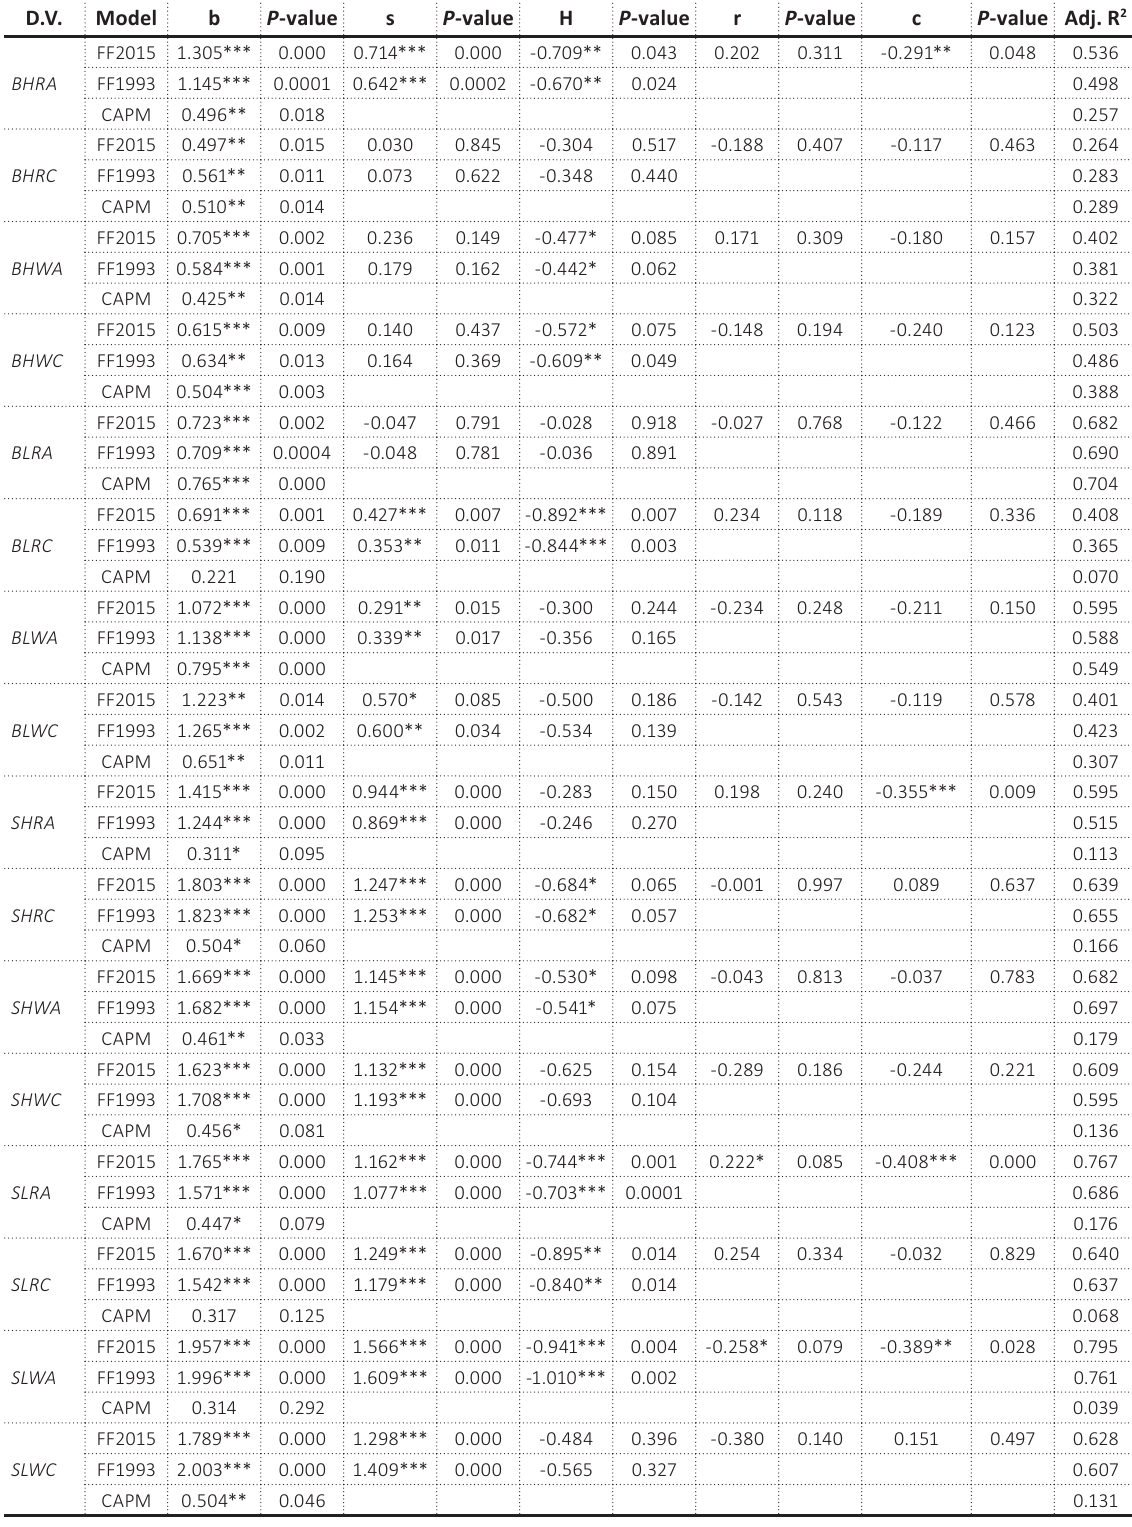
Table D1. Coefficients: 2x3 factors sort on Size and B/M, Size and OP, Size and Inv